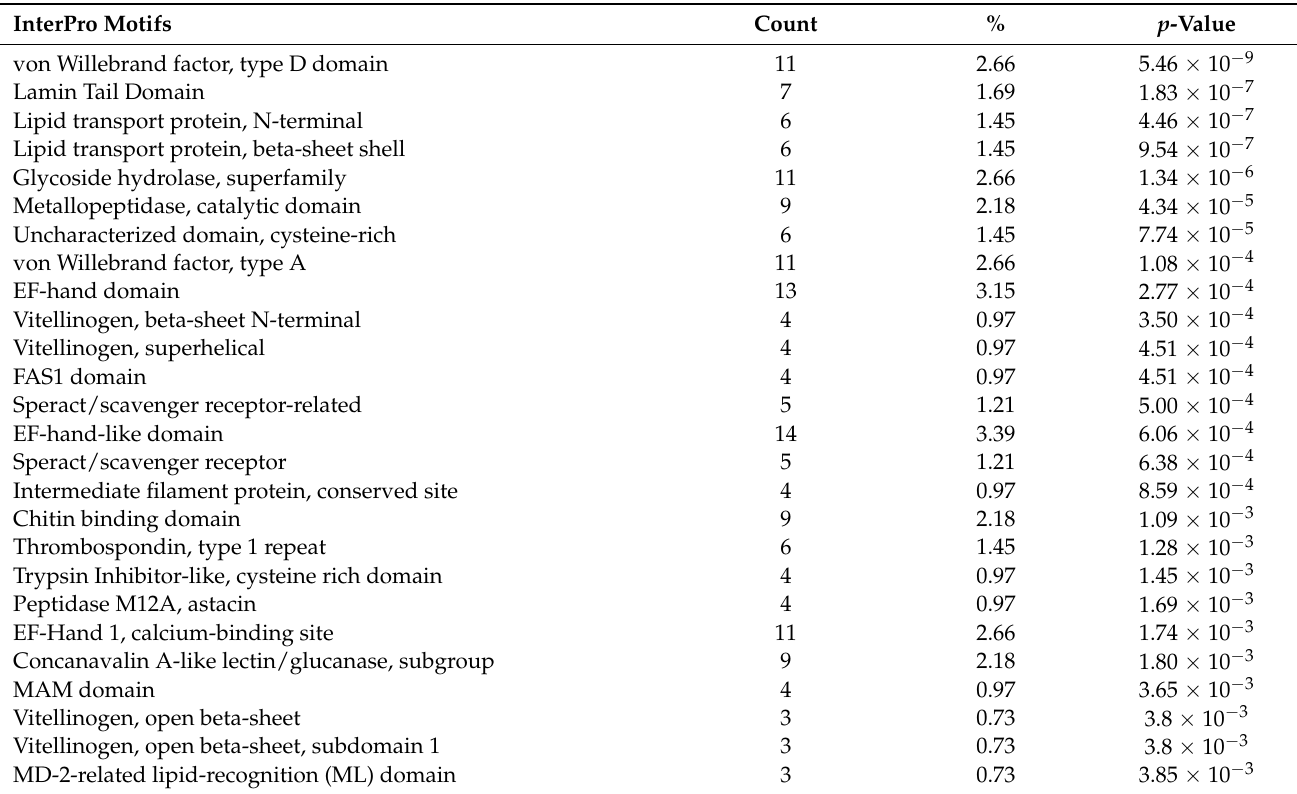
Table 3. Functional InterPro motifs analysis of the O. vulgaris skin mucus proteome by